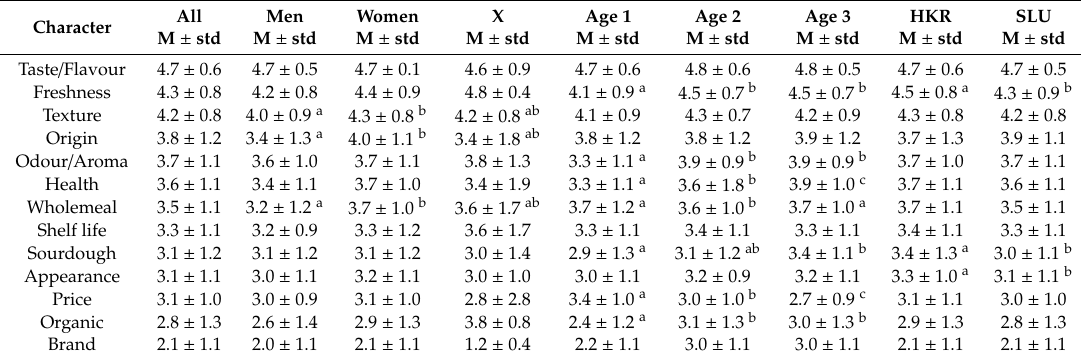
Table 3. Mean and standard deviations showing the importance of essential characteristics of the bread. Significant di ff erences are indicated with di ff erent letters. A 5-pointed scale was used where five was regarded as a very important factor, while one represented the least important factor.